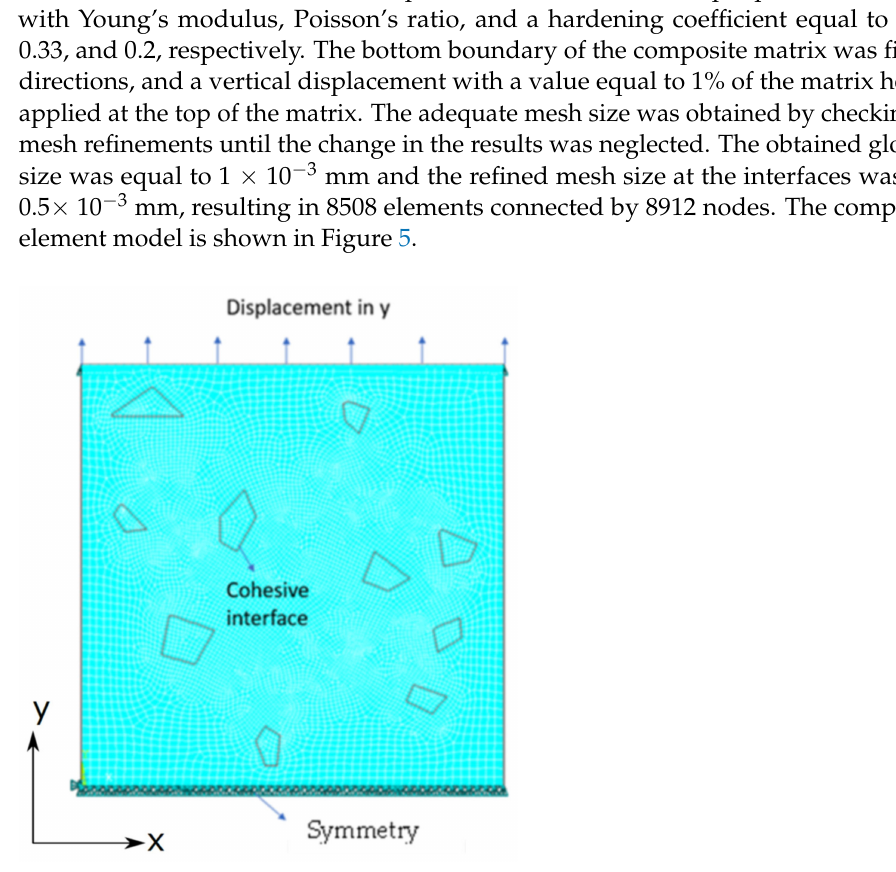
Figure 5. The finite element model showing the boundary conditions and the cohesive